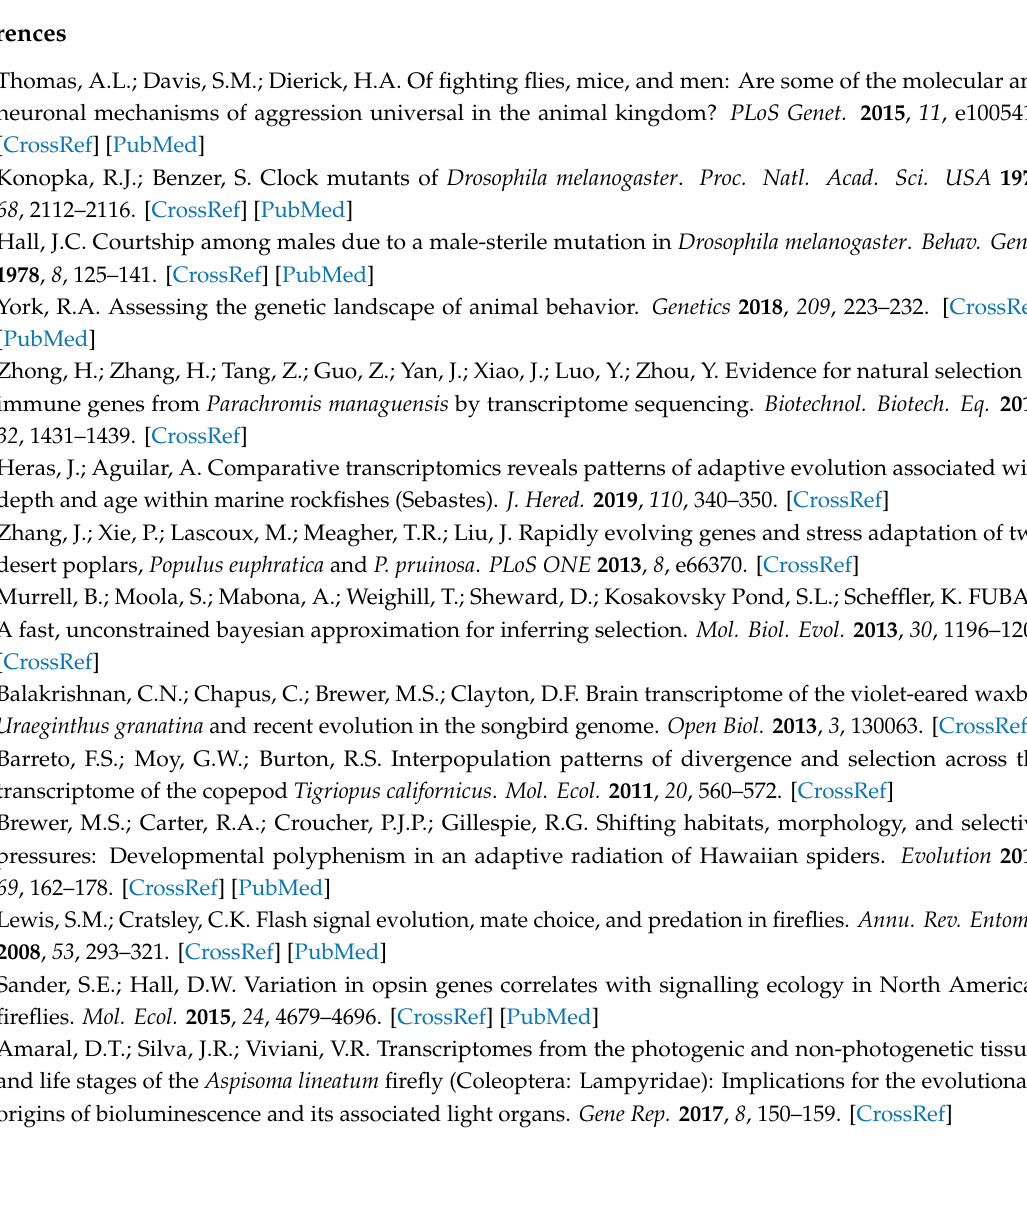
in a Photuris sp . vs. Photuris frontalis comparison. Table S5: Putative functions of genes under positive selection in a Photuris frontalis vs. Photinus pyralis comparison. Table S6: Putative functions of genes under positive selection in a Photuris sp. vs. Photinus pyralis comparison, Table S7: Assembly statistics for Photinus pyralis head tissue assembly based on all transcript contigs, Table S8: Assembly statistics for Photinus pyralis head tissue assembly based on only the longest isoform per gene, Table S9: BUSCO assembly scores, Table S10: FUSTr Results, Table S11: Homologs of genes under positive selection in a Photuris frontalis and Photinus pyralis head tissue comparison identified by BLAST, Table S12: Homologs of genes under positive selection in a Photuris sp. and Photinus pyralis head tissue comparison identified by BLAST. Additional supplementary data, including transcriptome assemblies,